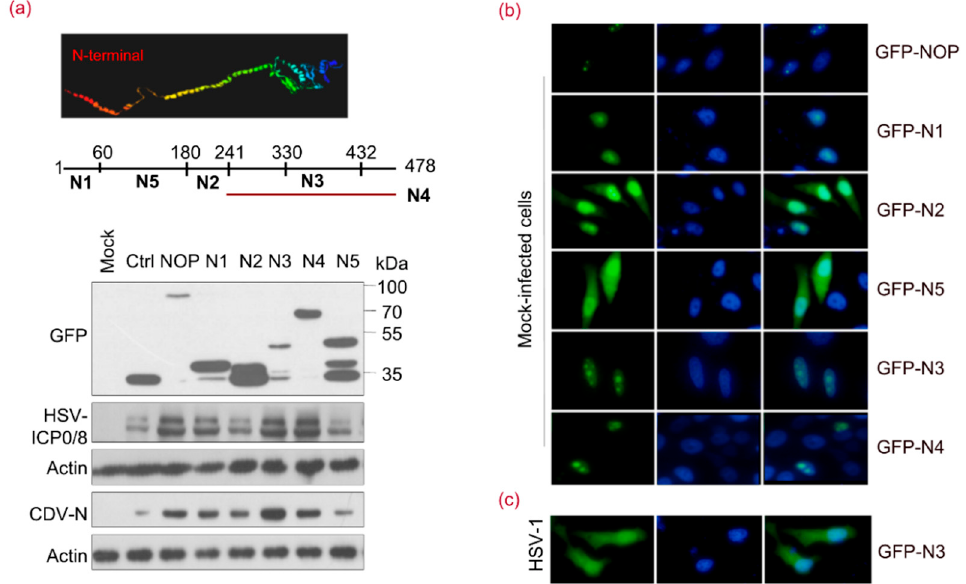
Figure 3. Sequences 330–432 of NOP53 Are Necessary for Viral Replication Priority. ( a ) HeLa cells in T-25 flasks were transfected with a control plasmid (Ctrl) or plasmids encoding GFP-tagged wt NOP53 or truncated NOP53 variants N1, N2, N3, N4, or N5 (5 µg each) for 36 h, followed by infection with HSV-1 or canine distemper virus (CDV) at 0.1 MOI for 48 h. Cell lysates were analyzed by immunoblotting with specific antibodies to detect GFP, HSV-ICP0, HSV-ICP8 and CDV-N, using actin as a control; ( b ) HeLa cells in 24-well plates were transfected with plasmids encoding GFP-tagged wt NOP53 or truncated NOP53 variants N1, N2, N3, N4, or N5 (500 ng each) for 36 h. The cells were fixed and examined with an Olympus microscope; ( c ) HeLa cells transfected with plasmids encoding GFP-tagged N3 were exposed to HSV-1 at 10 MOI for 12 h. The cells were fixed with 4% paraformaldehyde. Nuclei were stained with DAPI. N3 was visualized from the fused GFP fluorescence. Images were captured using 40 × objectives with an Olympus IX73 microscope.